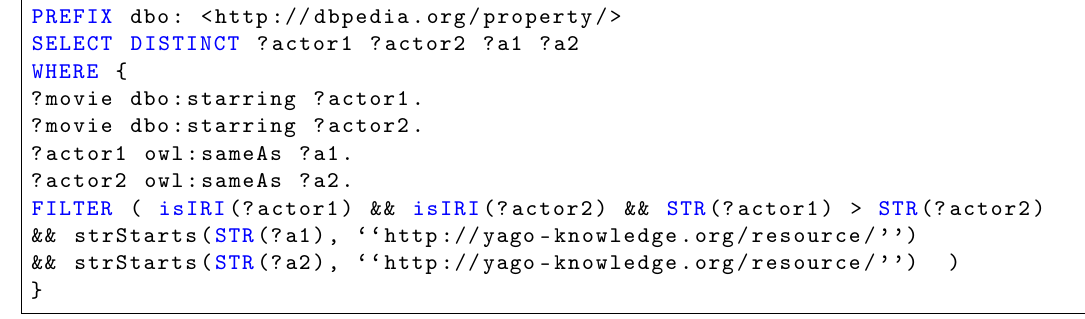
Figure 9. SPARQL query to extract co-acting network from DBpedia, with YAGO equivalent